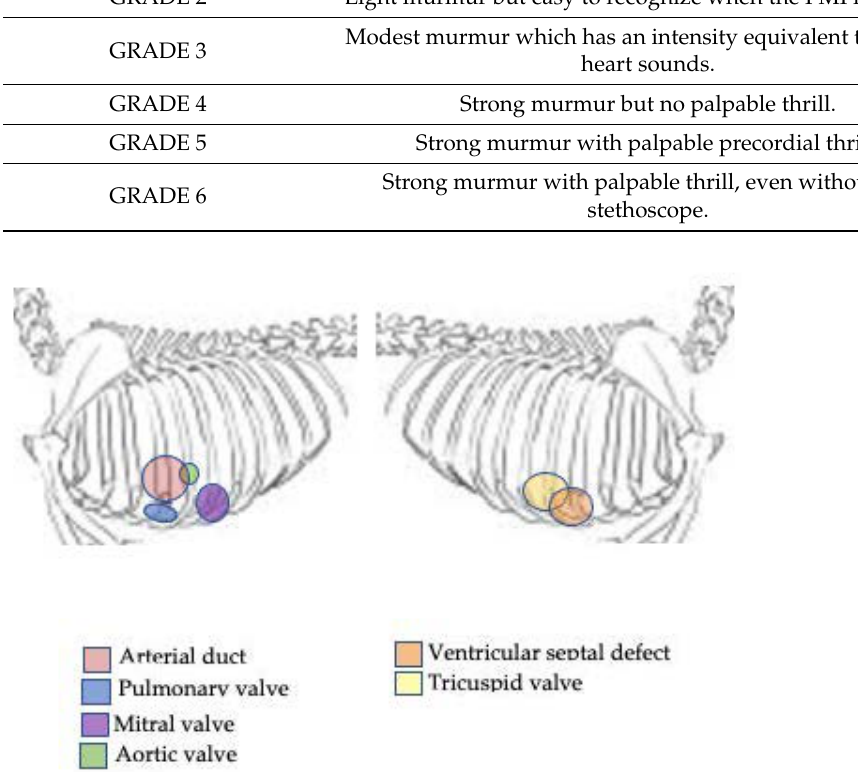
Figure 1. Different sites of auscultation originating the murmur in